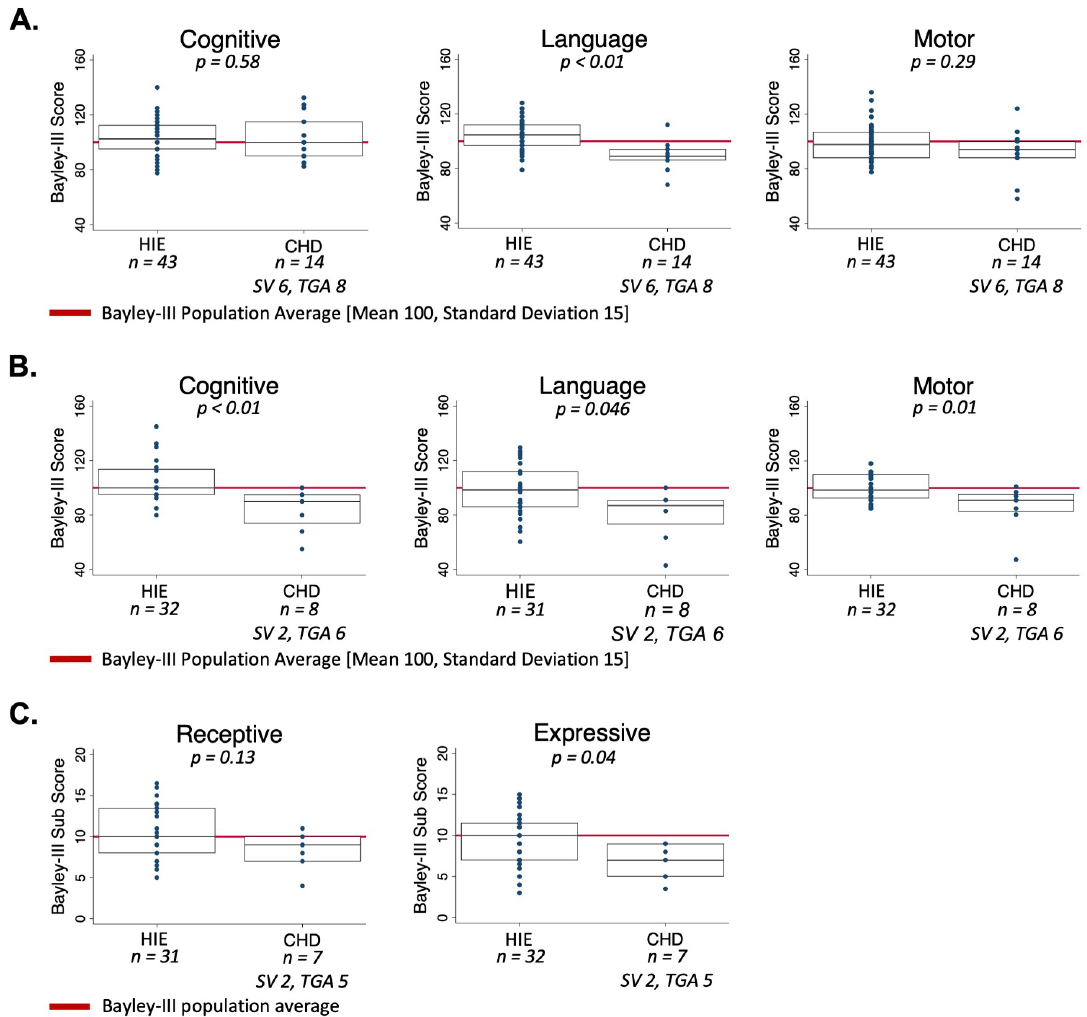
motor domains. (C) Bayley-III sub scores for receptive and expressive language at 30 months of